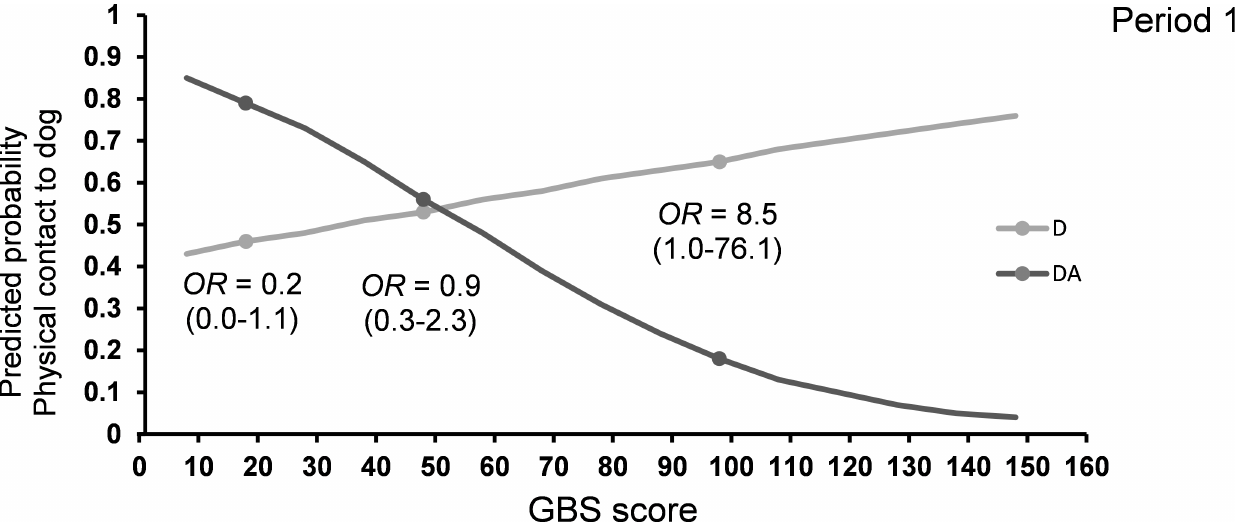
Fig 4. Predicted probability for physical contact with the dog in period 1 estimated for the range of GBS scores and separately for D and DA visits. D: visits with a dog, no activity, DA: visits with a dog, with activity. GBS scores of 18, 48 and 98 are marked with a dot. The odds ratios (OR) for each of these GBS-values are shown. The Gottfries-Br å ne-Steen Scale (GBS).